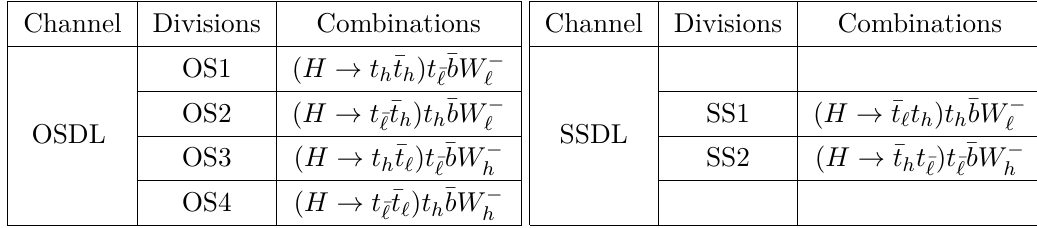
Table 1 . Divisions of the signal processes corresponding to different combinations of W decays that lead to the dilepton signals in the final states. the NLO effect [46]. The subdominant background is the tttbW ± process with bW ± in the final state not coming from a resonant top. The corresponding LO cross section is σ ( gg → tttbW ) = 0 . 623